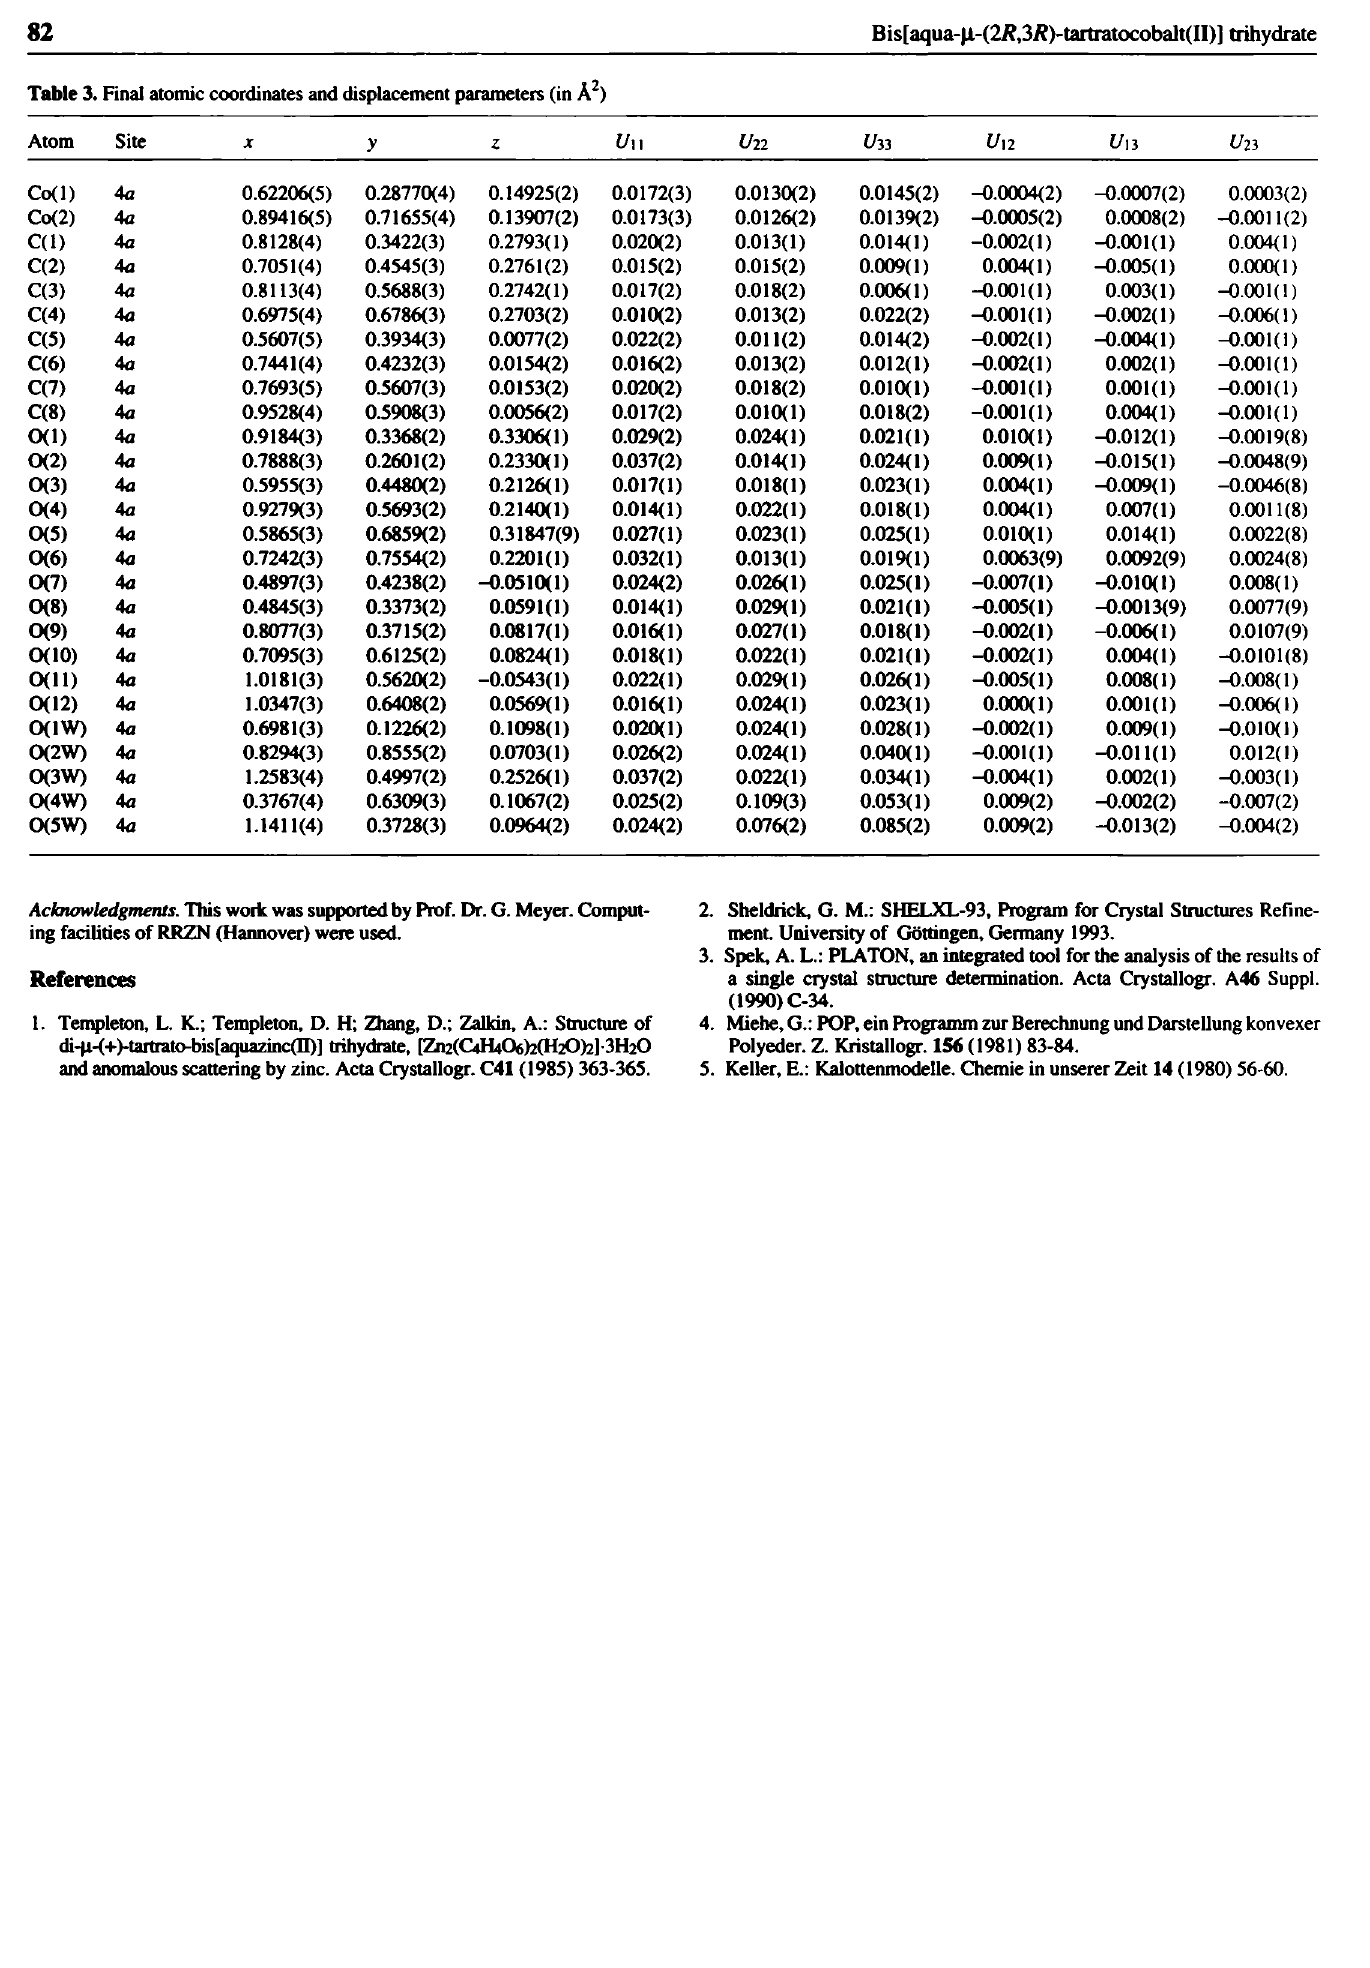
Table 3. Final atomic coordinates and displacement parameters (in Â 2